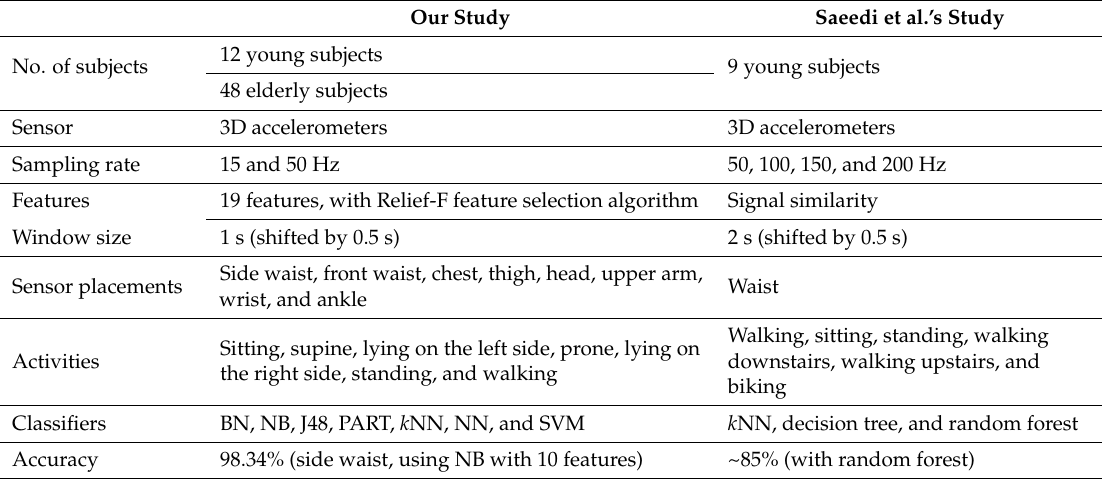
Table 8. Comparison between our work and the work presented in